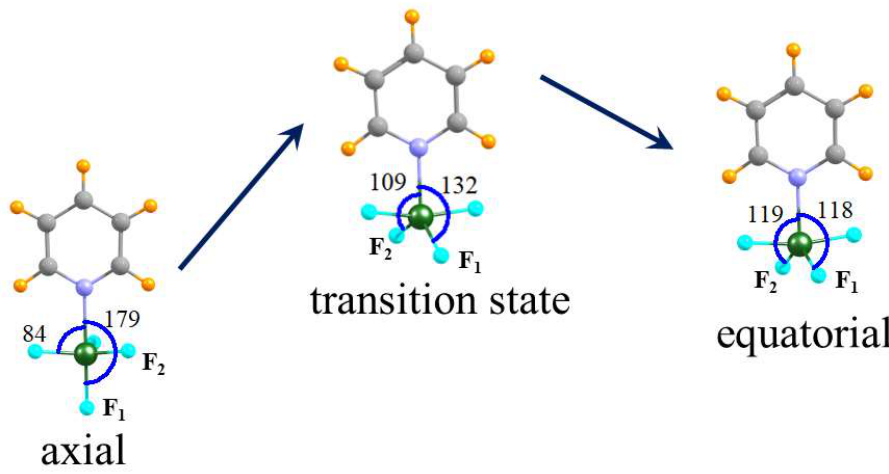
Figure 3. Gibbs free energy profile of transformation reaction between axial and equatorial conformers of the Py ··· GeF 4 complex. Data concerning energies and imaginary frequencies of TS are given in Table S2.